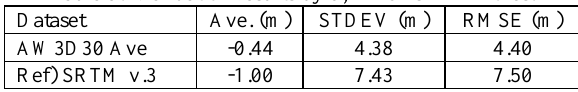
Figure 7. Histogram of height error evaluated by 5,121 CPs in 127 tiles (red: AW3D30 Ave DSM, and green: SRTM-3 version 3 as reference). Table 3. Validation results by 5,121 CPs in 127